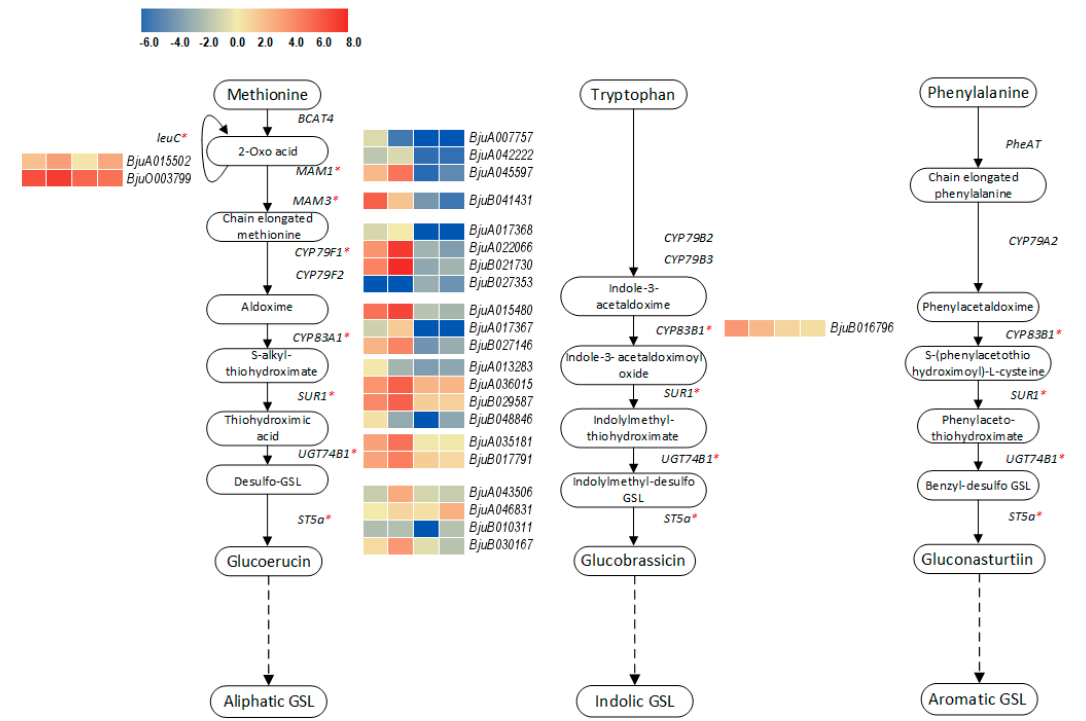
Figure 7. Schematic representation of genes associated with the core route of aliphatic, indole and aromatic glucosinolate biosynthesis in stem mustard. The expressions of DEGs in four stages are shown by the heatmap. The red asterisks indicate the DEGs (enzyme genes encoded by DEGs).